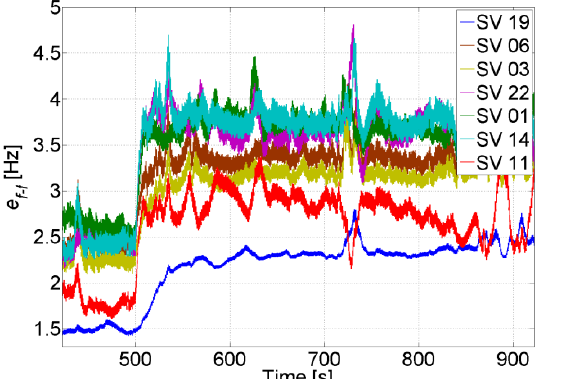
Figure 16. Feed-forward frequency uncertainty when four SVs are in